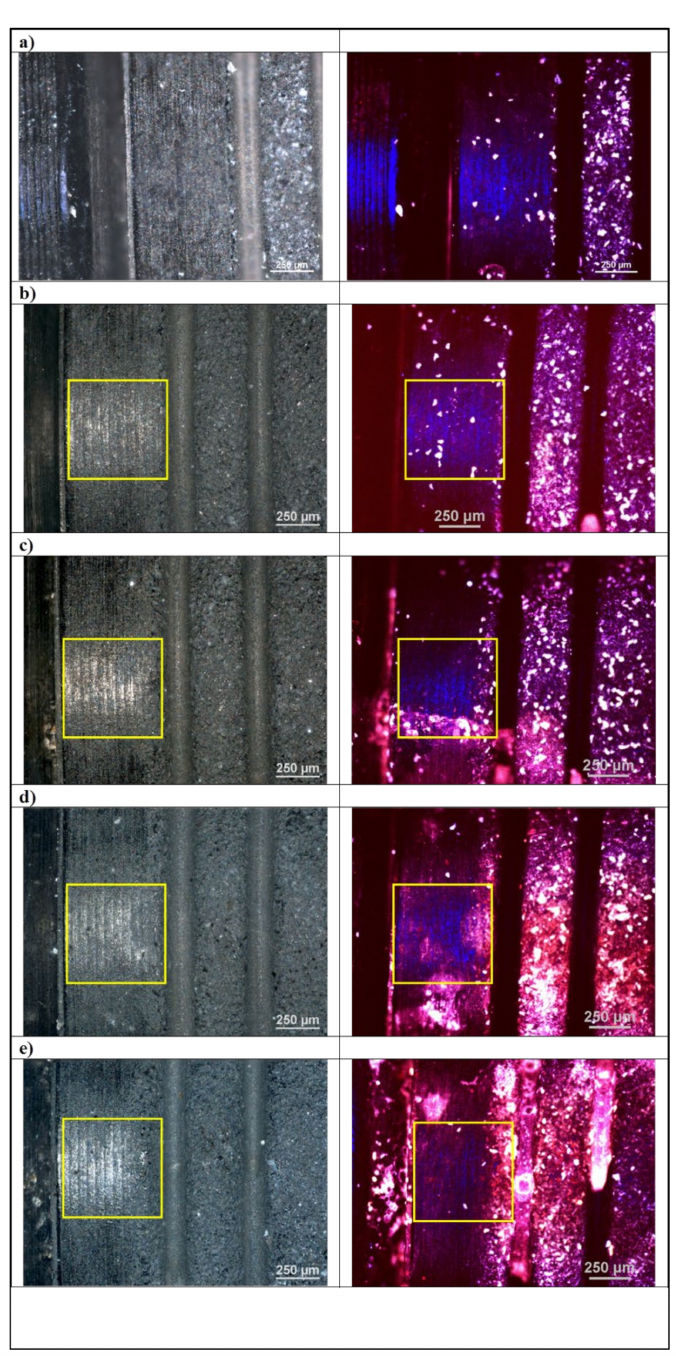
Figure 1. Optical and confocal microscopy. Micrograph of the implant sample surface ( left column ) under optical microscope and ( right column ) under confocal microscope, laser wavelength λ = 405